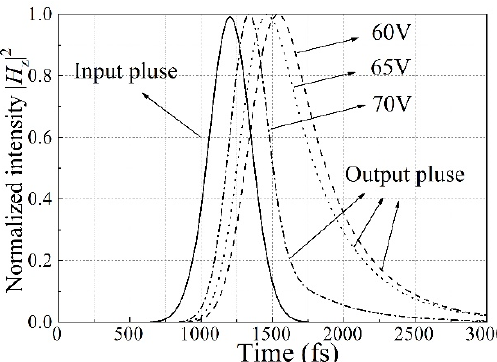
Figure 7. The normalized input pulse and output pulse; the input pulse is denoted by the black solid line, and other lines are the output pulse.